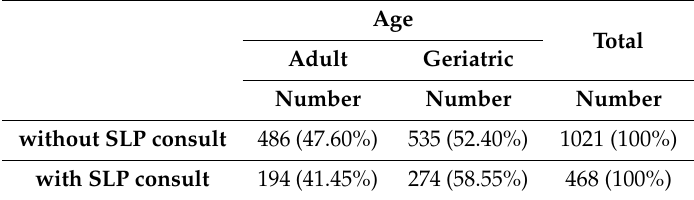
Table 1. Percentage of speech-language pathologist (SLP) consults from each age